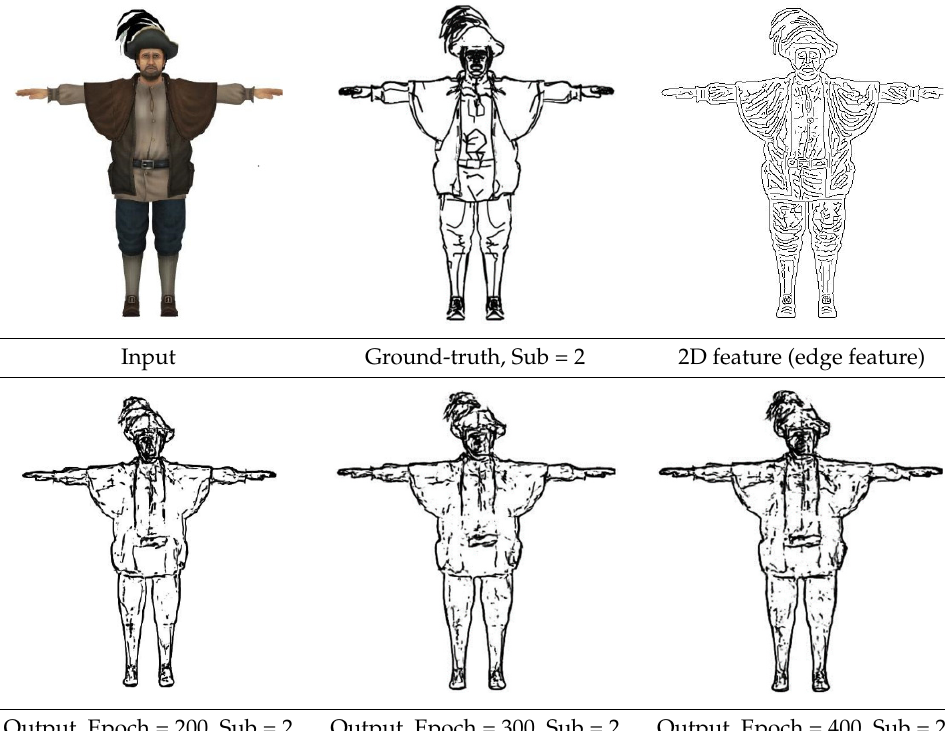
Table 4. Result of the line drawing extraction using a conditional GAN (Example 2).